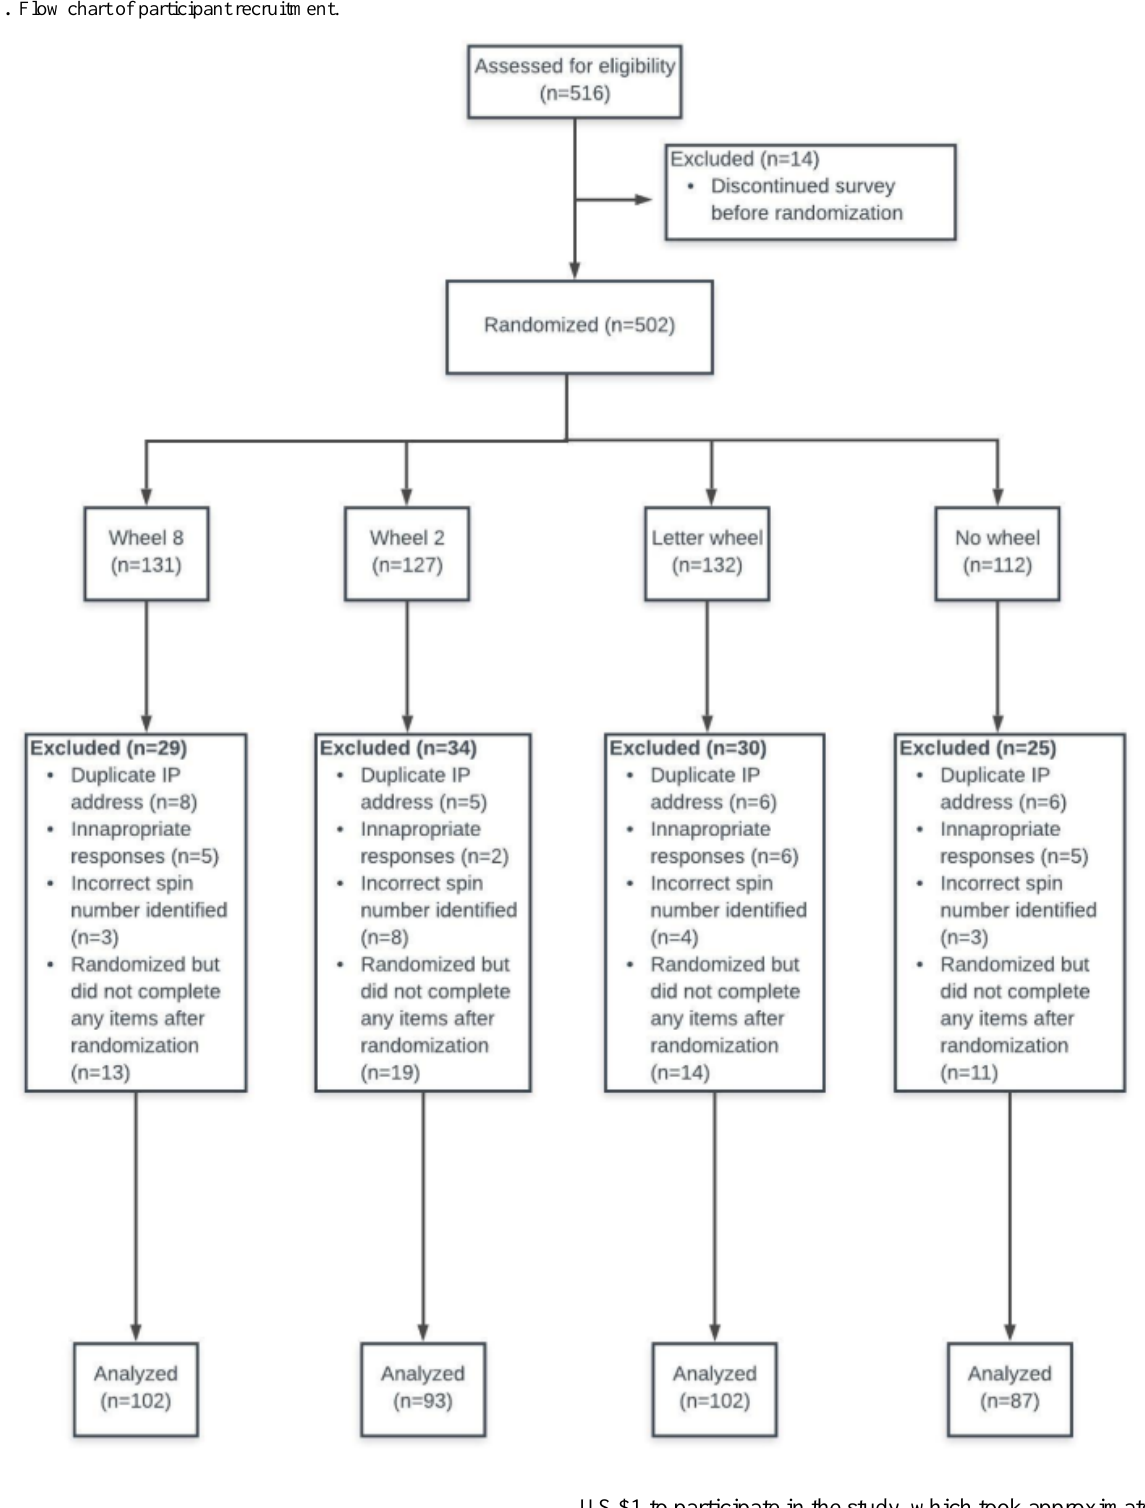
Figure 1. Flow chart of participant